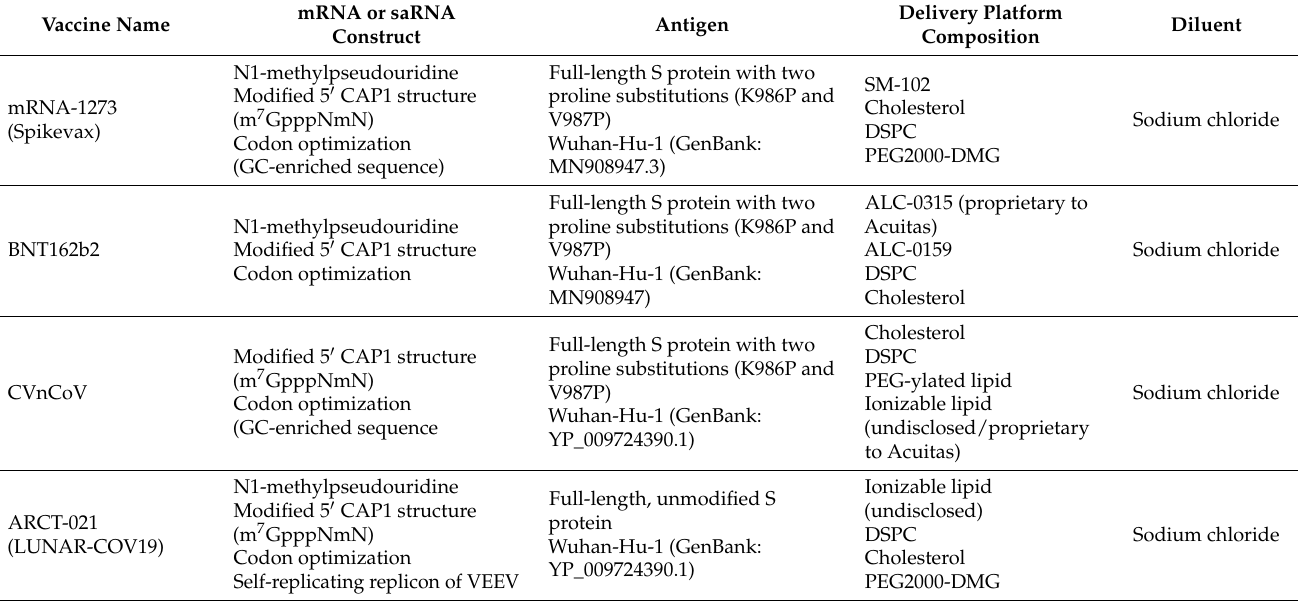
Table 6. Components of the major RNA-based vaccine against COVID-19: characteristics of the mRNA or saRNA and antigen used and its delivery system